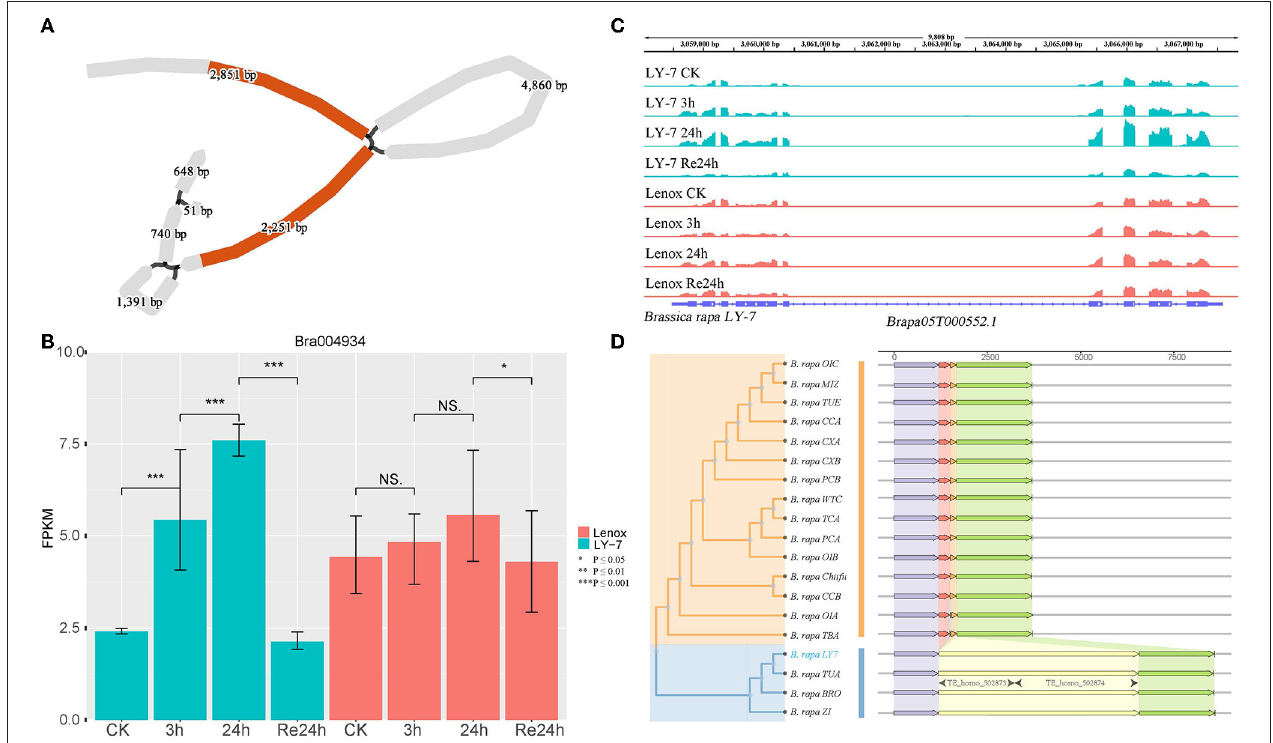
FIGURE 5 | Structure variant of HDG1 in B. rapa “Longyou-7” genome. (A) BLAST hit of gene HDG1 in the pan-genome and 4860bp of structural variation detected within it; (B) The differential expression of HDG1 between “Longyou-7” and “Lenox” within 48h; (C) Coverage of RNAseq reads in the region of gene HDG1 in “Longyou-7” genome and their abundance; (D) Neighbor-joining tree clustering and the gene structure characteristics of gene HDG1